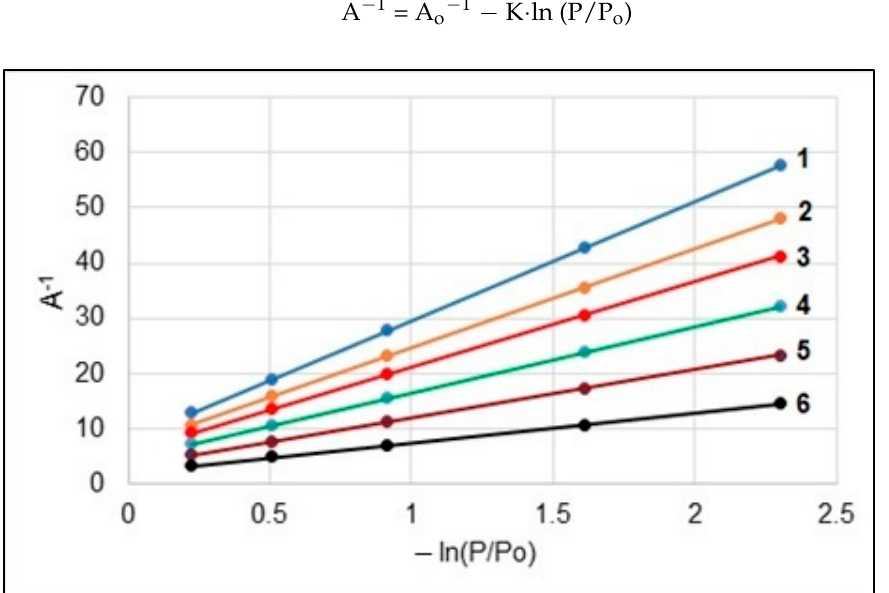
Figure 4. Linear form of sorption isotherms for samples of MCC (1), CC (2), SP (3), SPM (4), VF (5), and AC (6). Table 2. Maximum moisture absorption and wetting enthalpy for cellulose samples.